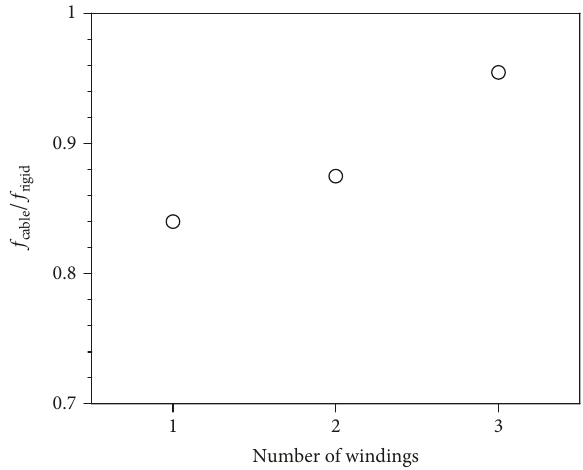
Figure 12: Normalized natural frequency of the solar panel for di ff erent numbers of cable windings.